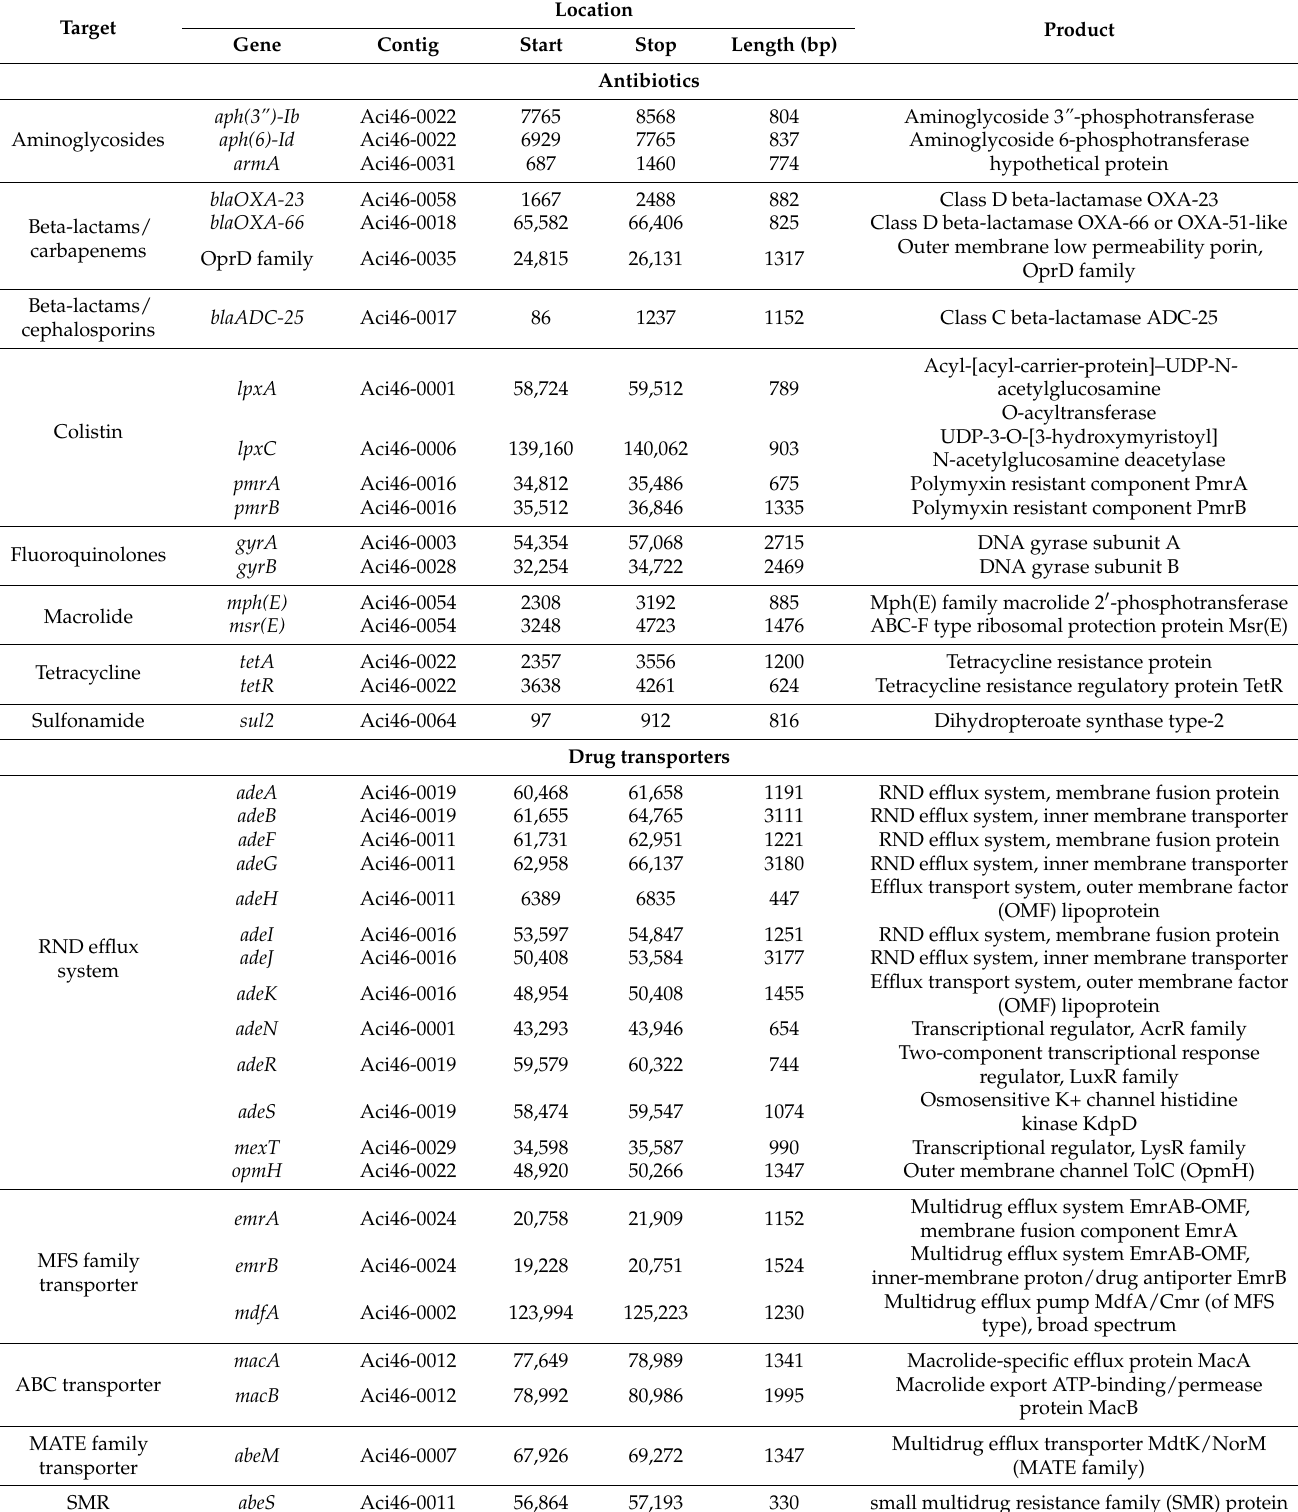
Table 3. List of predicted antibiotic resistance and drug transporter